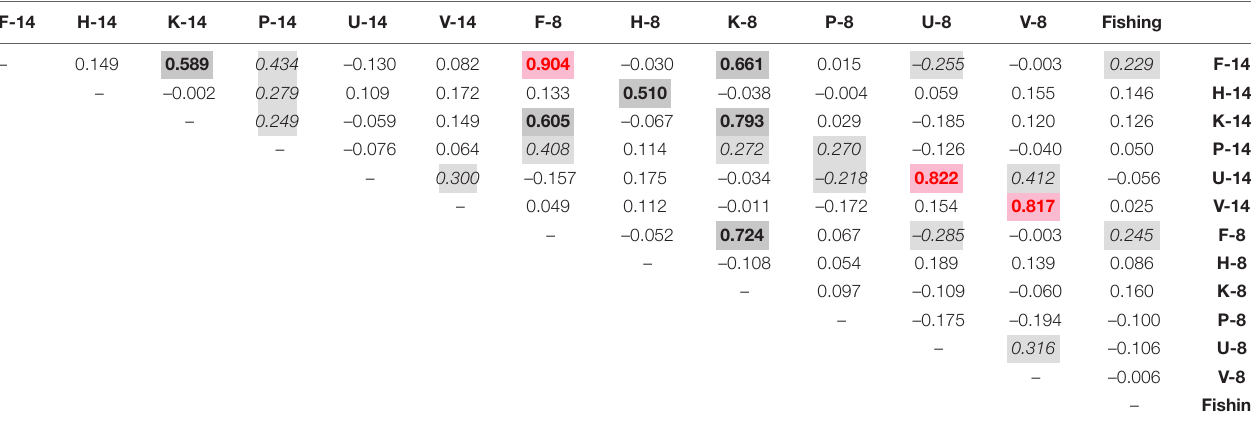
TABLE 2 | Pearson correlation coefficients between all prediction rasters (14 variable and 8 variable predictions per taxa: F, Funiculina quadrangularis ; H, Halipteris spp.; K, Kophobelemnon stelliferum ; P, Pennatulidae spp.; U, Umbellula spp., V - Virgulariidae) and the fishing raster. F-14